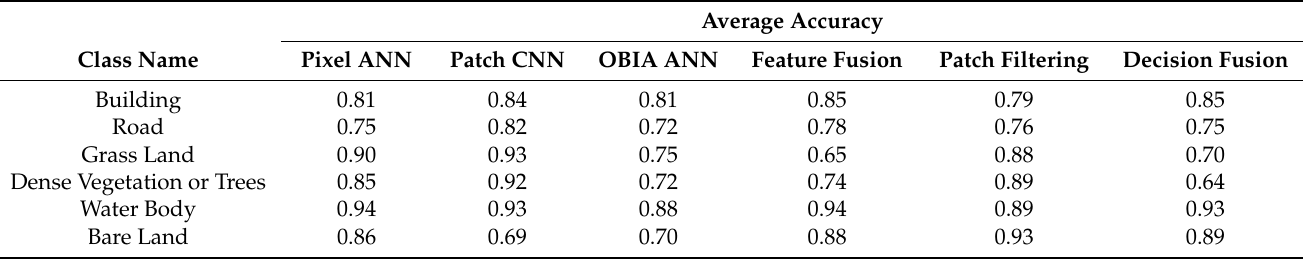
Table 6. Per-class accuracies obtained for each classification method using the training area dataset. Average Accuracy